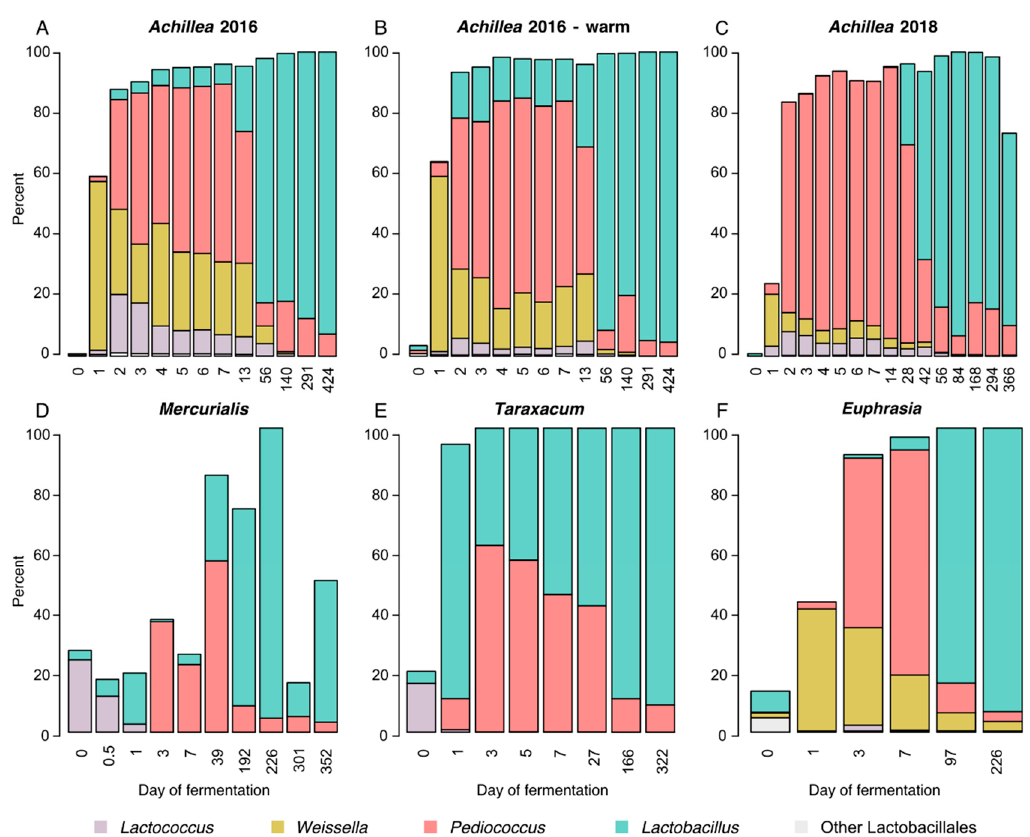
Figure 5. Percentages of Lactobacillales during the fermentation of Achillea ( A – C ), Mercurialis ( D ), Taraxacum ( E ), and Euphrasia ( F ). Achillea 2016 was also fermented at permanently warm conditions during the initial 7 days ( B ).